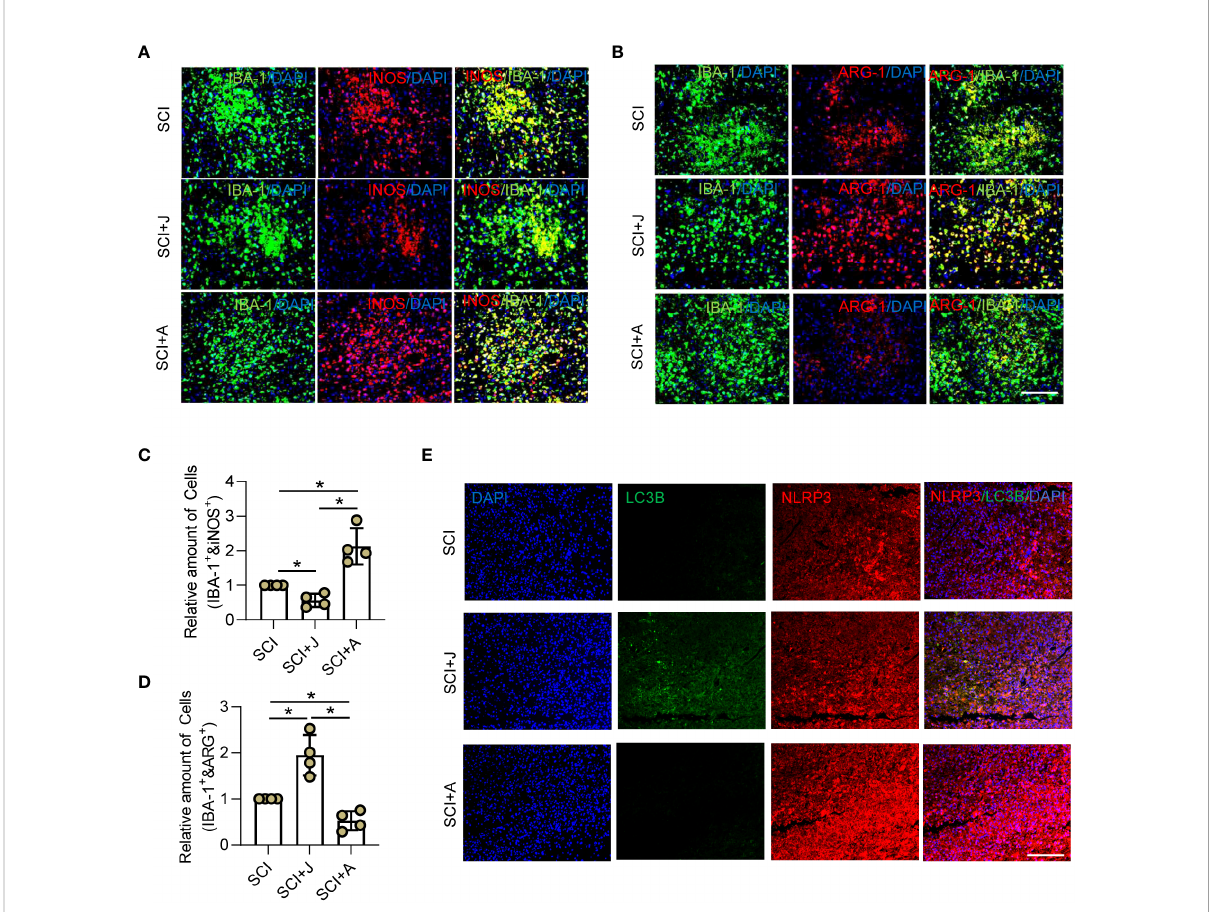
FIGURE 4 CB2R alleviated in fl ammation by promoting NLRP3-autophagosome formation in injured cords post-SCI. On day 3 post-SCI with CB2R activation by JWH-133 or inactivation by AM630, (A) IF staining of iNOS (red) and IBA-1 (green); (B) IF staining of ARG-1 (red) and IBA-1 (green). Scale bar = 100 m m. (C) Quantitative analysis of the number of iNOS + microglia. (D) Quantitative analysis of the number of ARG-1 + microglia. (E) IF staining of NLRP3 (red) and LC3B (green) on day 3 post-SCI. Scale bar = 100 m m. * p <